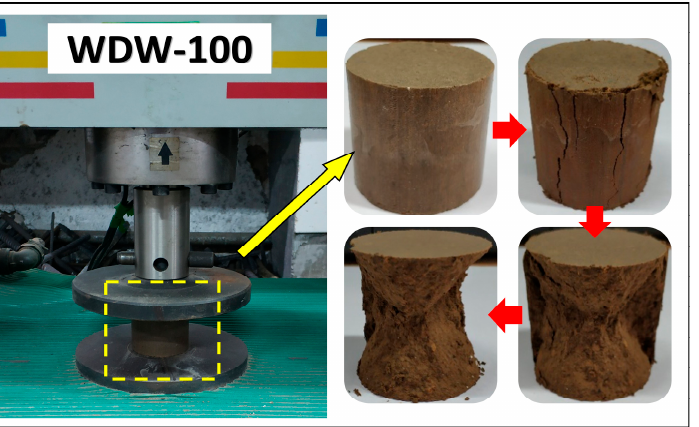
Figure 2. The unconfined compressive strength test (The red arrows represented the process of failure of the